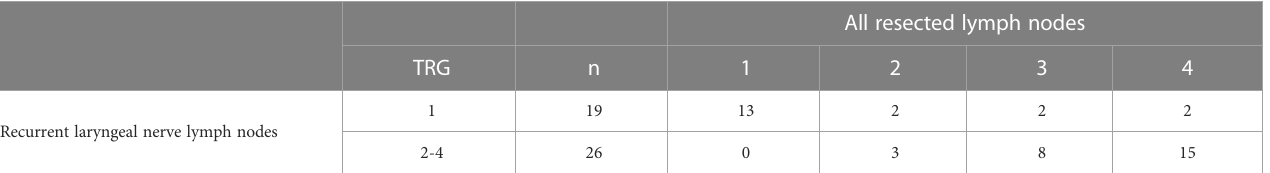
TABLE 2 Tumor regression grading (TRG) in all resected lymph nodes and recurrent laryngeal nerve lymph